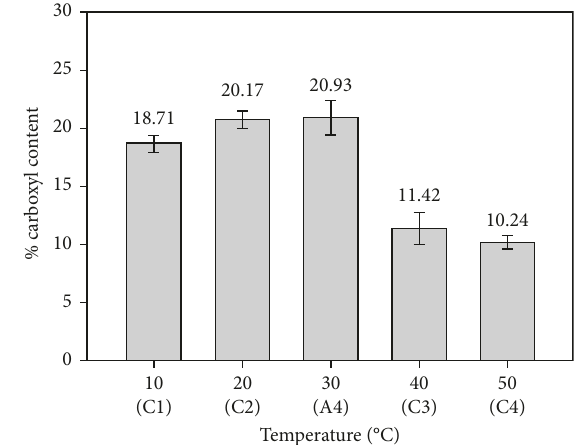
Figure 3: Effect of different ratios of HNO content of the OC. The reactions were performed at 30 ° C and 1.4% (w/v) of NaNO 2 for 24 hours.